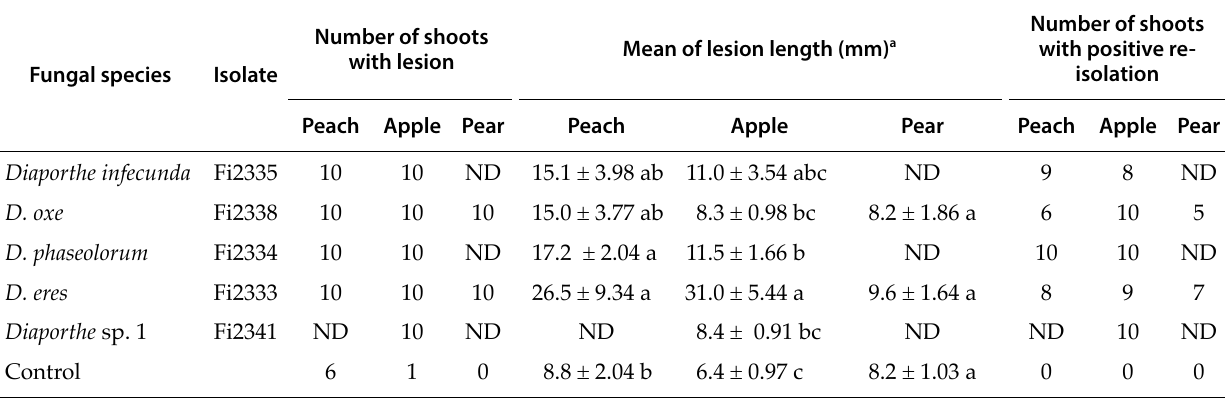
Table 4. Numbers of shoots developing lesions after artificial inoculation of five Diaporthe spp. inoculated on branches of peach, apple or pear trees, mean lesion lengths and numbers of shoots with positive re-isolation of inoculated isolates.